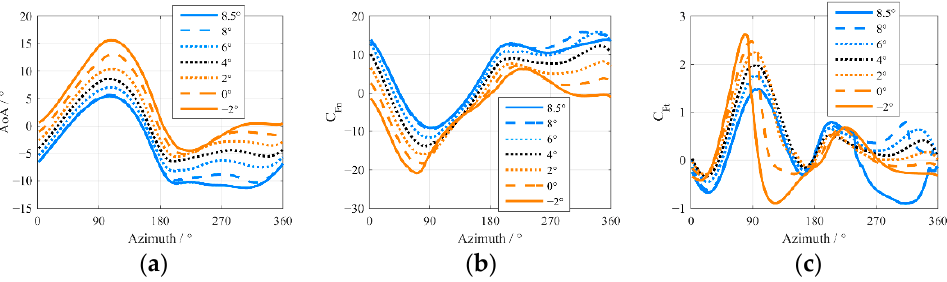
Figure 6. Instantaneous variables of a blade element on the equator with different fold angles: ( a ) angle of attack (AoA); ( b ) 𝐶 (cid:3007)(cid:3041) and ( c ) 𝐶 (cid:3007)(cid:3047) . ( a ) angle of attack (AoA); ( b ) C Fn and ( c ) C Ft .